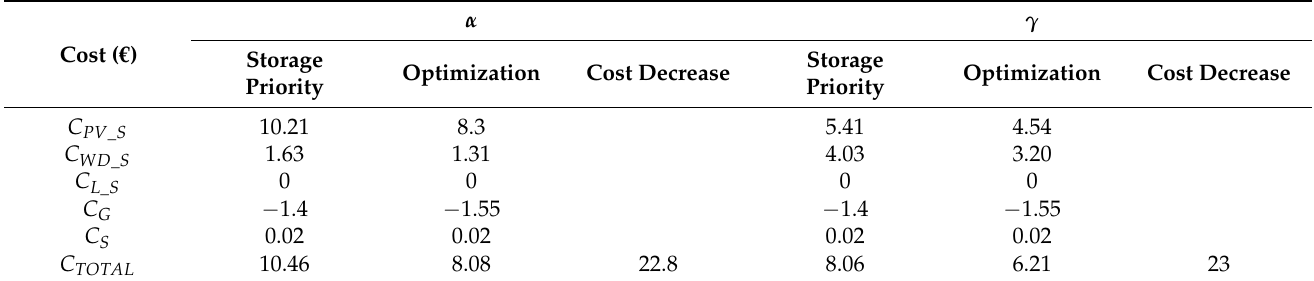
Table 7. Energy cost calculation for α and γ